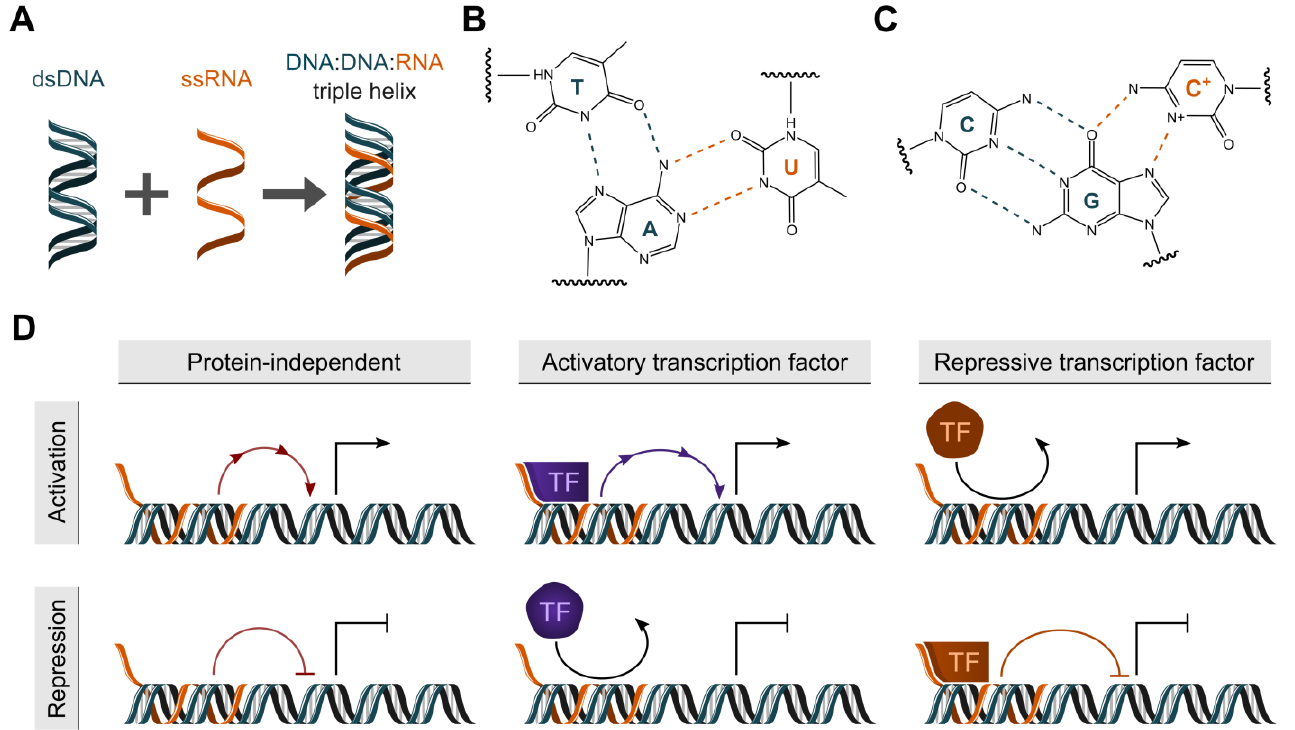
Figure 1. Overview of DNA:DNA:RNA triple helix formation ( A ) Schematic of DNA:DNA:RNA triple helix formation between double-stranded DNA and single-stranded RNA. ( B – C ) Canonical Watson – Crick and Hoogsteen (red) base pairings which permit the formation of DNA:DNA:RNA triple helices. ( D ) Putative mechanisms by which DNA:DNA:RNA triple helix formation permits the control of gene expression via interactions with gene loci and transcription factors.